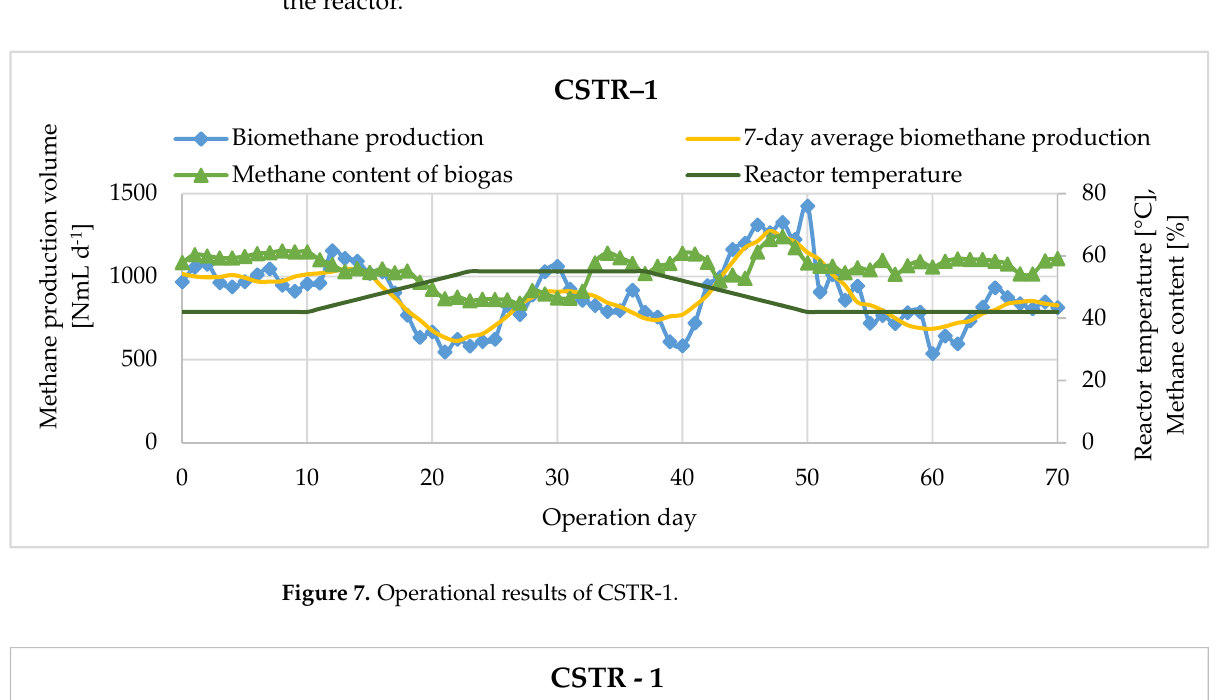
Figure 7. Operational results of CSTR-1.